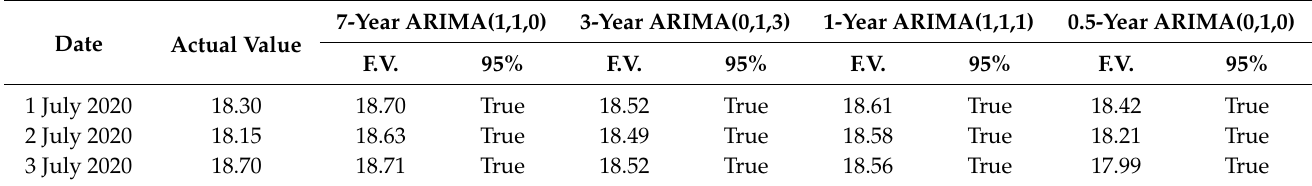
Table 4. Comparison of the predicted and actual values of each data interval for 3086 Wayi.